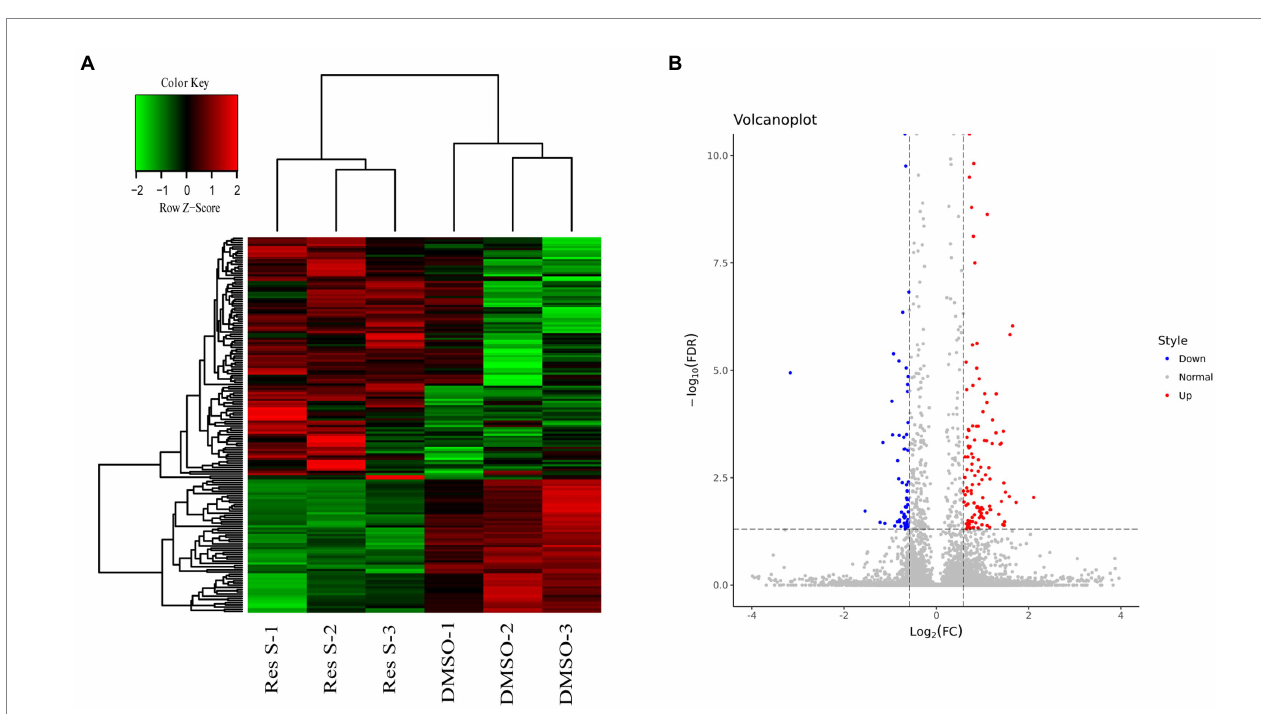
FIGURE 4 (A) The heatmap of the DEGs between Resinacein S treated group and DMSO group. (B) The volcano plot of the DEGs between Resinacein S treated group and DMSO group.